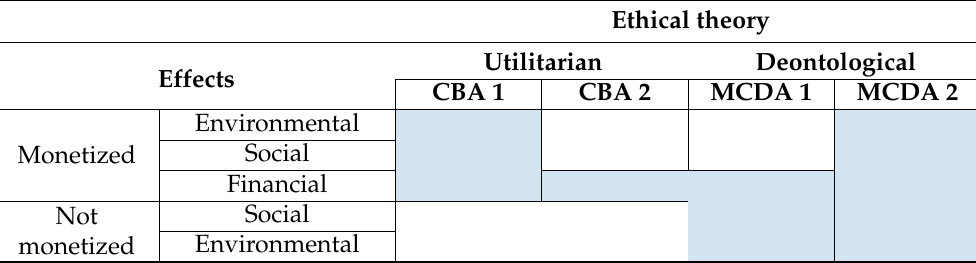
Table 1. Examples of how the decision-support methods CBA and MCDA can relate the utilitarian and deontological ethical theories and to monetized and not-monetized economic, social, and environmental effects. Blue color represents the included dimensions.